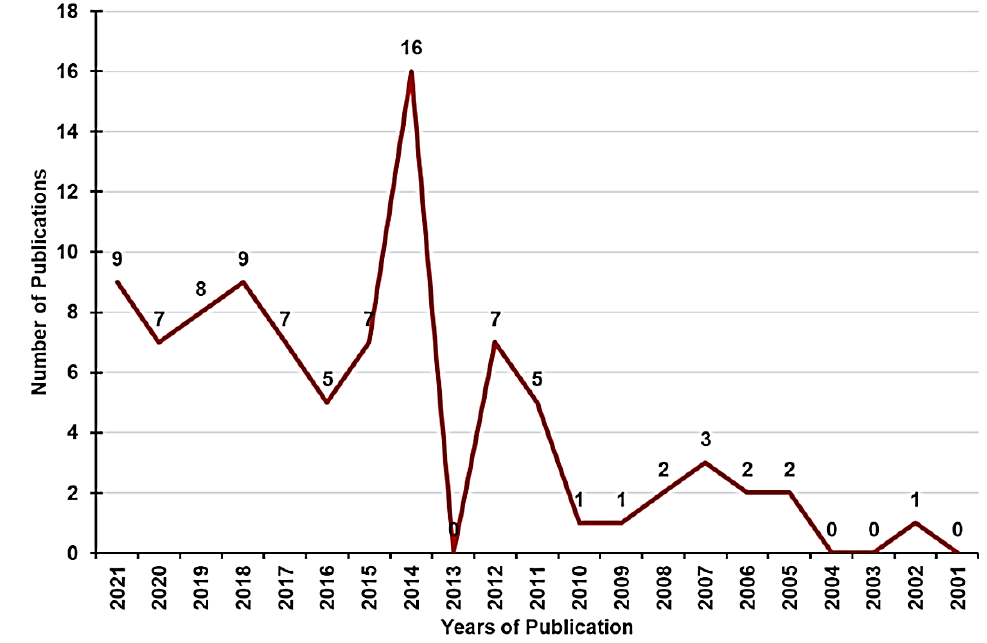
Figure 2. Number of publications per year of the last 20 years according to Scopus.